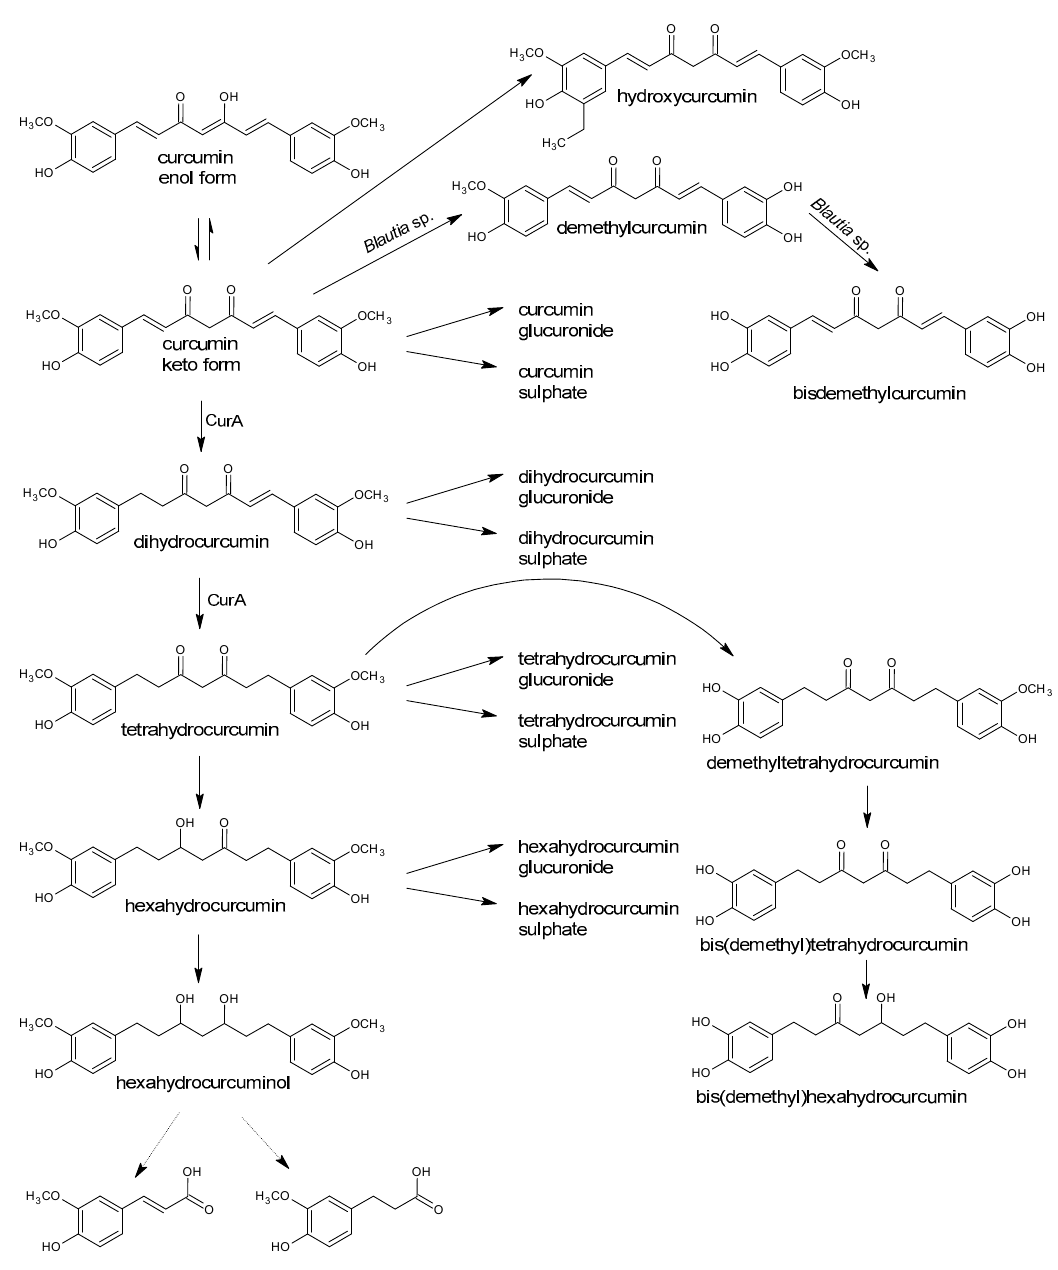
Figure 20. Metabolic pathway of curcumin. Reactions conducted by E. coli CurA and Blautia sp. are indicated. Based on [274,325,326,328–330].